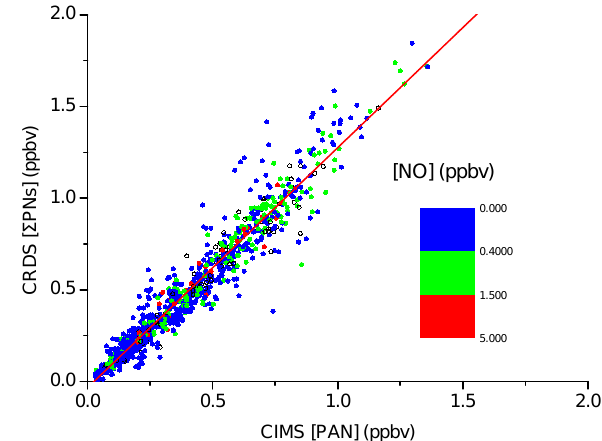
Figure 17. PARADE data: comparison of PAN derived by the TD- CIMS with the TD-CRDS measurement of (cid:54) PNs. The (cid:54) PNs data have been corrected as described in the text. The data are colour- coded according to [NO] mixing